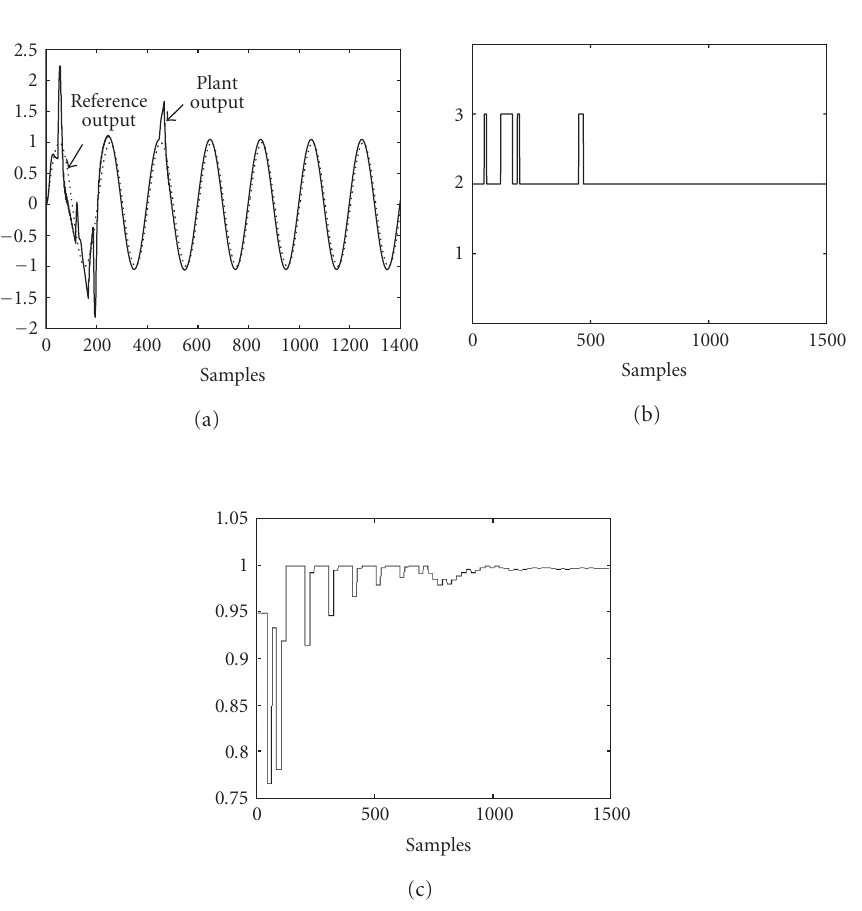
Figure 4.4. (a) Plant output and reference output. (b) Active controller. (c) Evolution of α -weighting